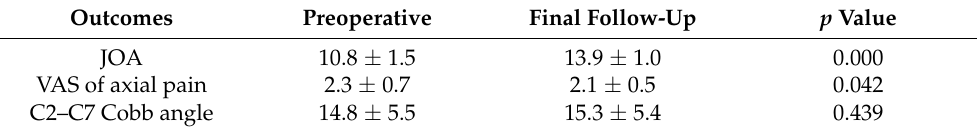
Table 2. Pre- and postoperative